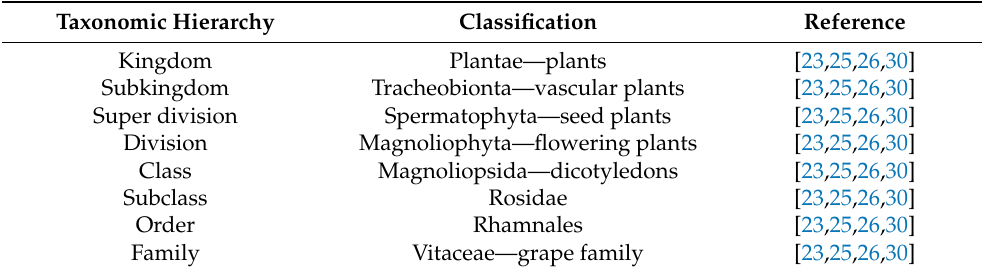
Table 1. Taxonomy of the Vitaceae family.